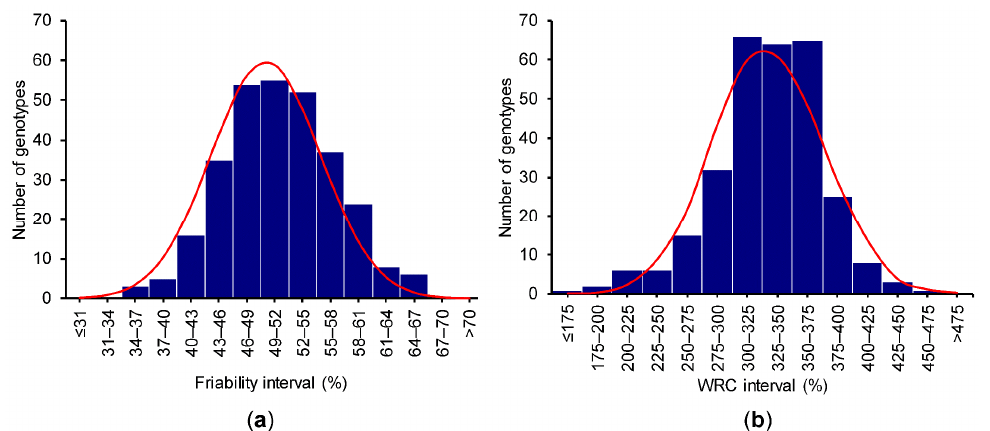
Figure 1. Data distribution of the selected traits: ( a ) bran friability and ( b ) water retention capacity; normal distribution curve shown in red.